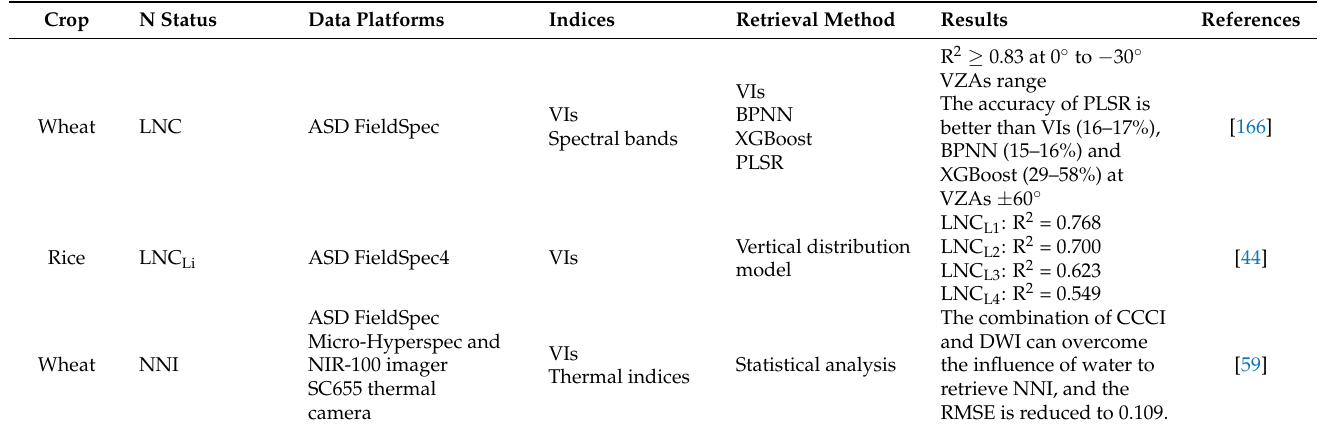
Table 2 covers case studies from different